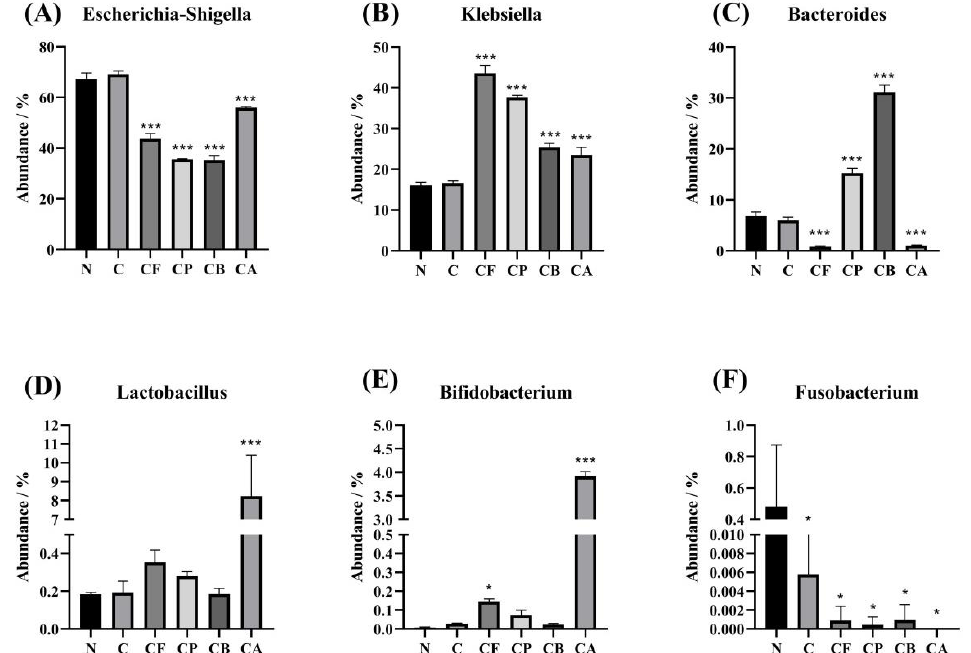
Figure 6. Significant differences among the five substrates and the control at the genus level. Asterisks indicate significant difference between N group and other five groups, respectively: * ( p < 0.05), and *** ( p < 0.001). Values are means ± SD for n = 3.